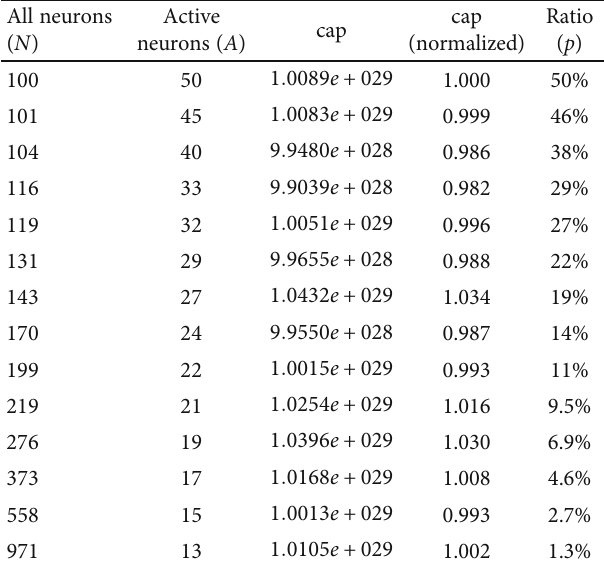
Figure 1: The relationship between cost and p and r . Table 1: The value of N and A and the corresponding value of cap and p